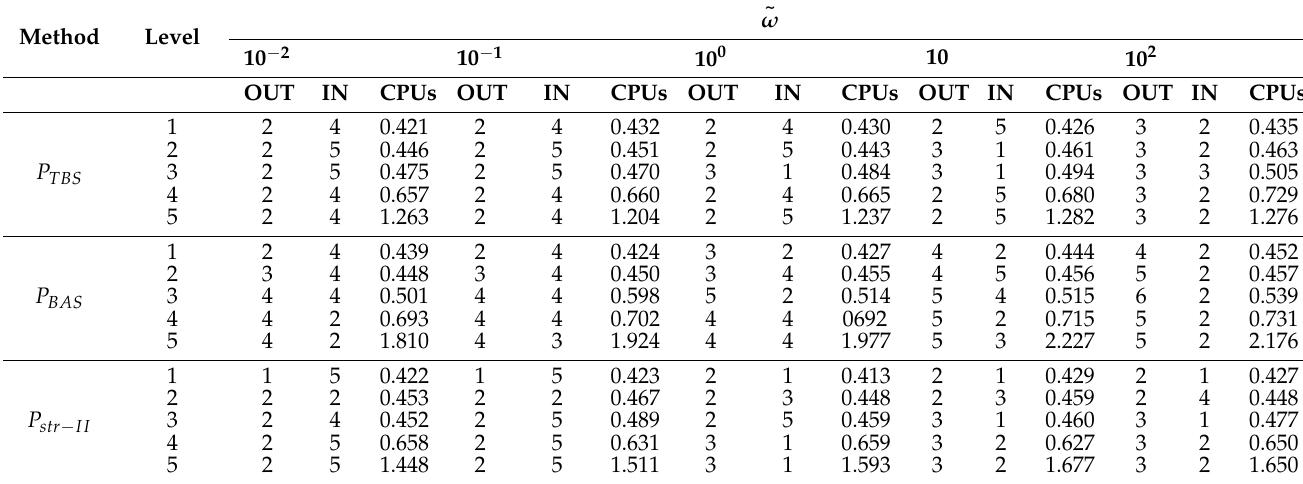
Table 5. Different mesh refinement levels and (cid:101) ω , the result of the preconditioned GMRES (5) in the 2D case, with ε = 10 − 4 . Method